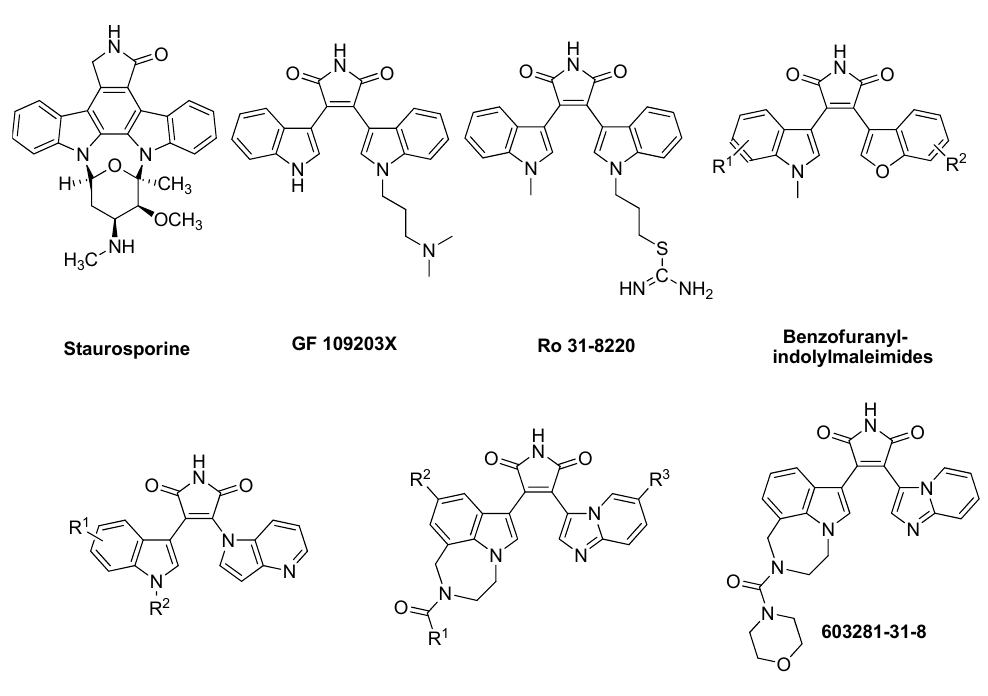
Figure 1. GSK-3 β